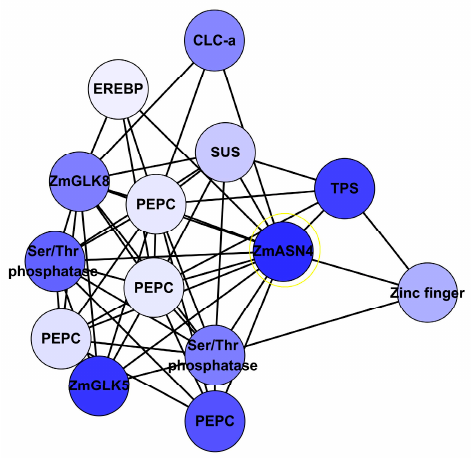
Figure 8. Sub-network of ZmASN4 interacted with its 13 neighbours. Note: CLC-a: chloride channel protein-a; EREBP: ethylene-responsive element binding protein; PEPC: phosphoenolpyruvate carboxylase; SUS: sucrose synthetase; TPS: terpene synthetase; ZmASN4: asparagine synthetase; ZmGLK5: G2-like 5 transcription factor; ZmGLK8: G2-like 8 transcription factor. Blue represents down-regulated gene.